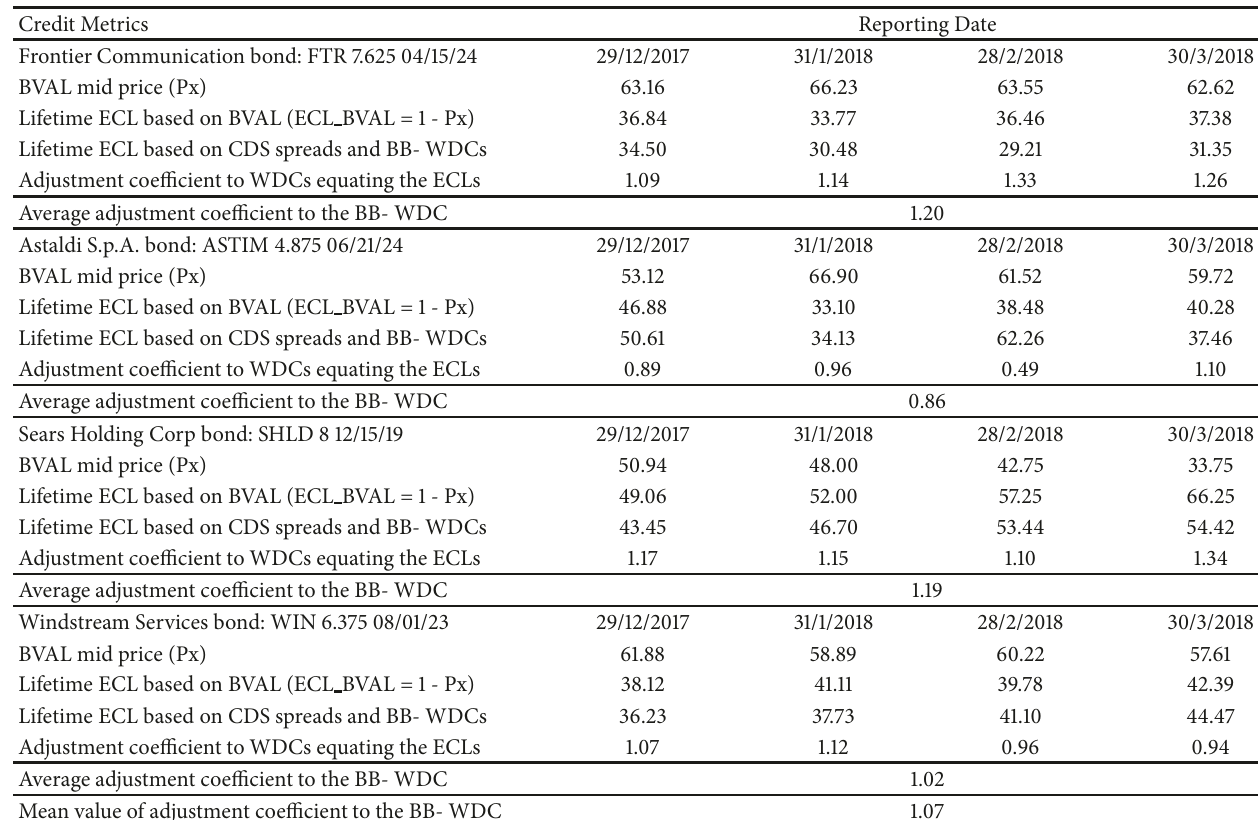
Table 12: Adjustment coefficient for below BB- grade to be applied to BB- WDCs: CDS-based ECL versus BVAL price